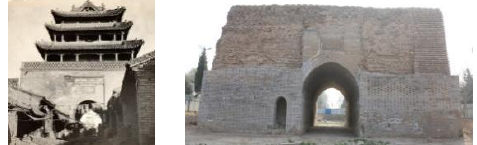
Figure 2. Ruins of Drum Tower System in